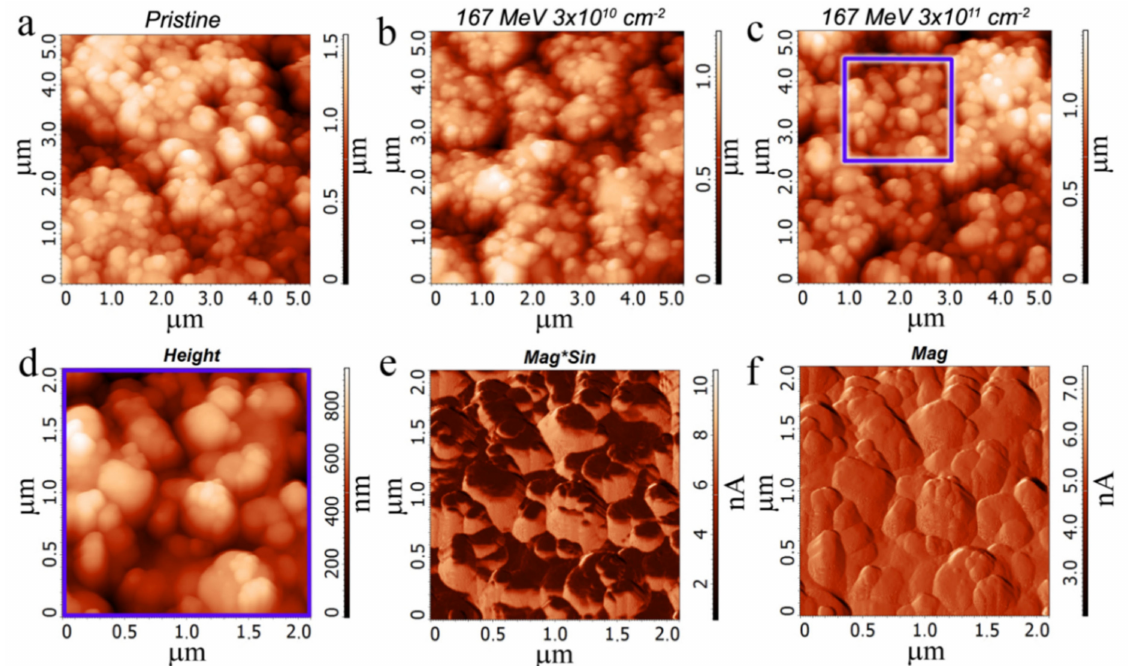
Figure 4. ( a – c ) AFM images of the pristine ( a ) and 167 MeV ion irradiated active FG–PVA layers. The ion fluence was equal to 3 × 10 10 ( b ) and 3 × 10 11 cm − 2 ( c ). An enlarged surface fragment ( c ) is shown in ( d ). ( d – f ) The FG–PVA film irradiated with 167 MeV Xe ions (fluence was 3 × 10 11 cm − 2 ) was recorded in different regimes (height, MagSin, and